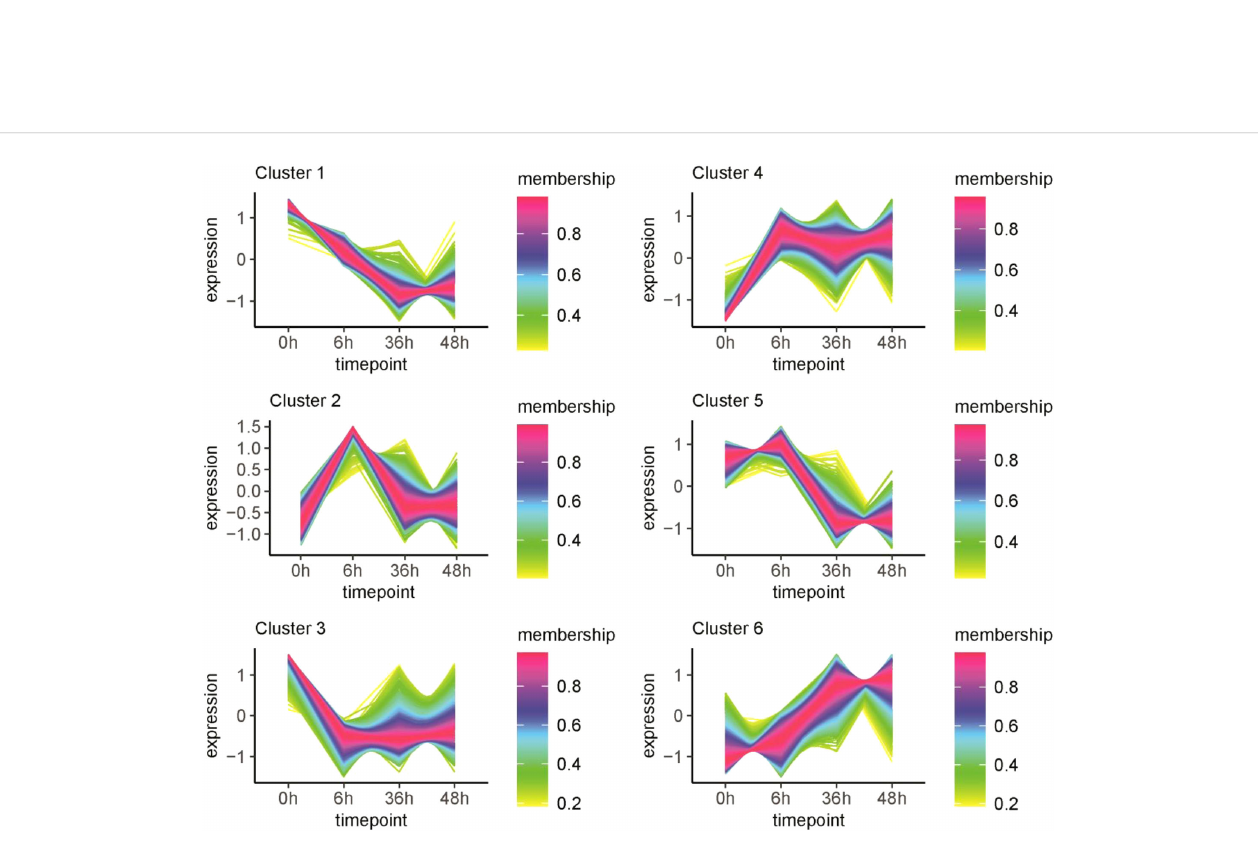
FIGURE 3 Cluster analysis of gene expression patterns in RM-210 tubers at different time points of light treatment. The Y-axis represents the deviation of the gene expression. The X-axis represents the sampling time